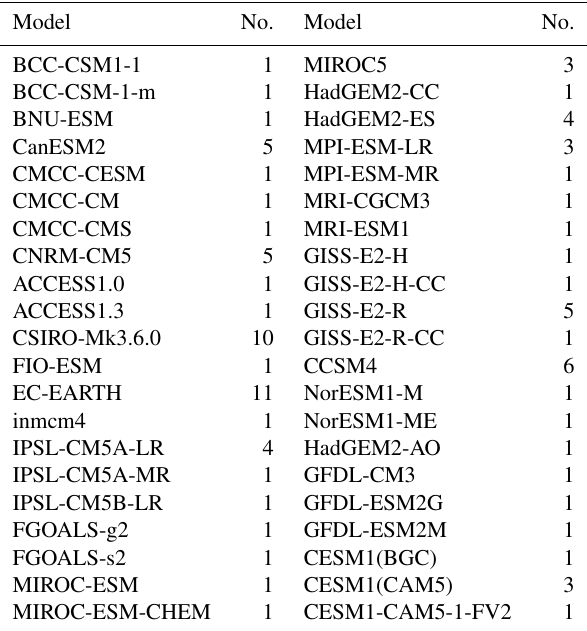
Table 1. List of CMIP5 models (with number of realizations) used for terrestrial snow analysis of both historical and future periods.